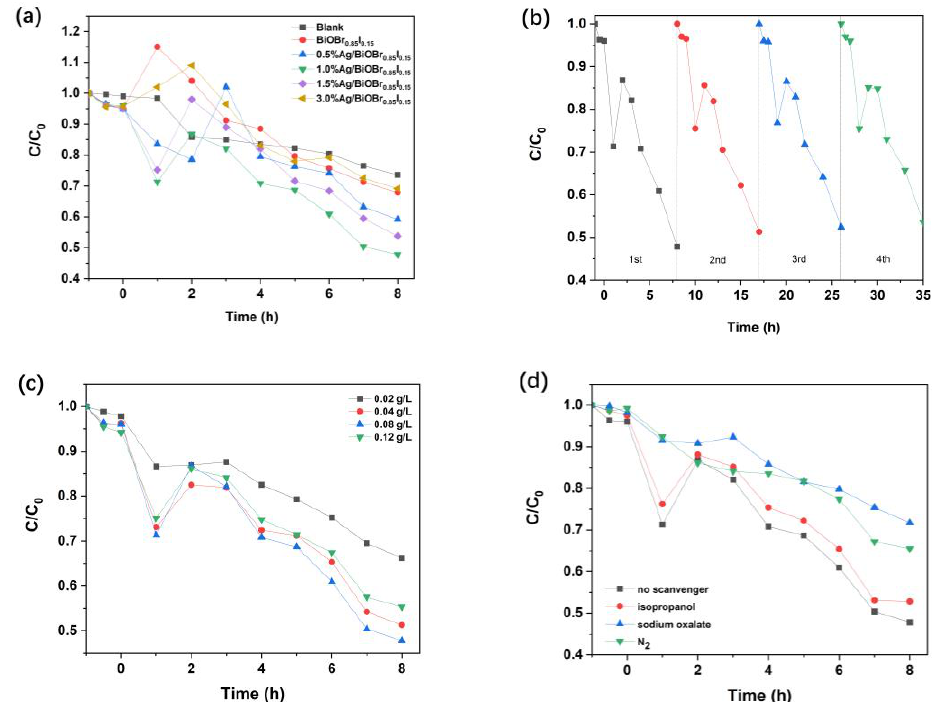
Figure 9. Photocatalytic activities of different catalysts ( a ), cycling runs of 1.0% Ag/BiOBr 0.85 I 0.15 sample for the removal of NH 4+ -N ( b ), effect of catalyst dosage on NH 4+ -N degradation rate ( c ), and the NH 4+ -N degradation efficiencies of 1.0% Ag/BiOBr 0.85 I 0.15 under different scavengers ( d ).